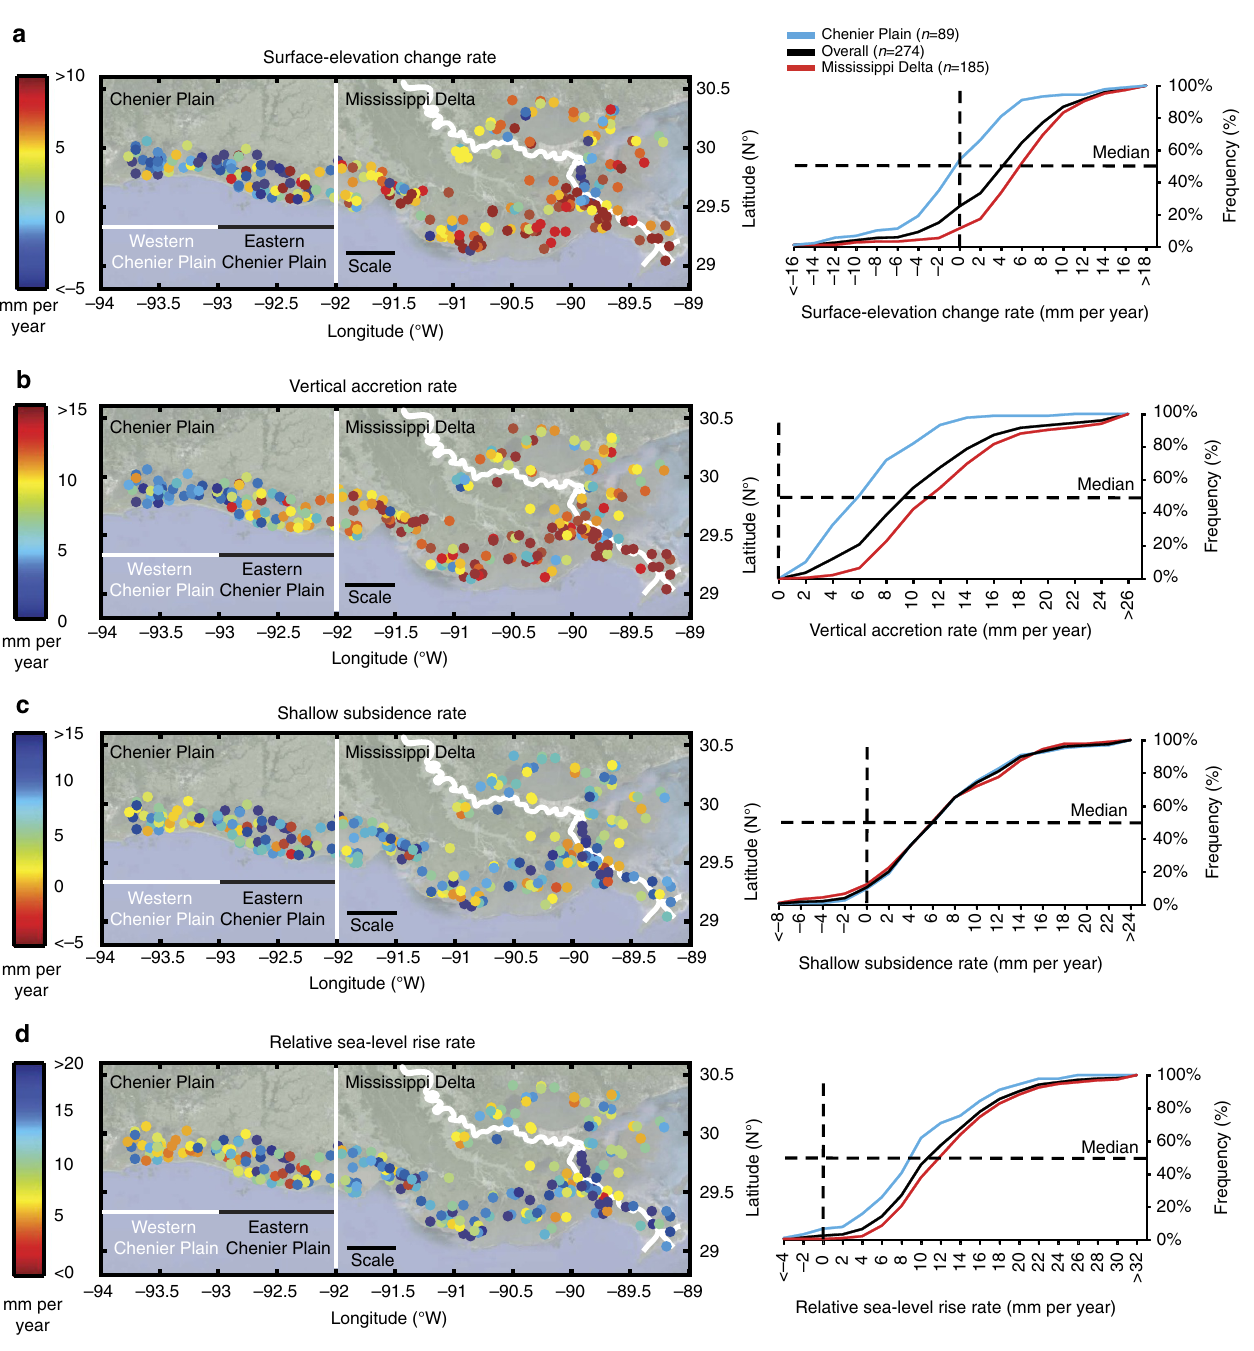
Figure 2 | Spatial pattern and cumulative frequency distribution of present-day wetland conditions in coastal Louisiana. Rates of ( a ) SEC; ( b ) VA; ( c ) SS; and ( d ) RSLR at 274 sites. Frequency histograms of these data sets are provided in Supplementary Fig. 1. Scale bar,